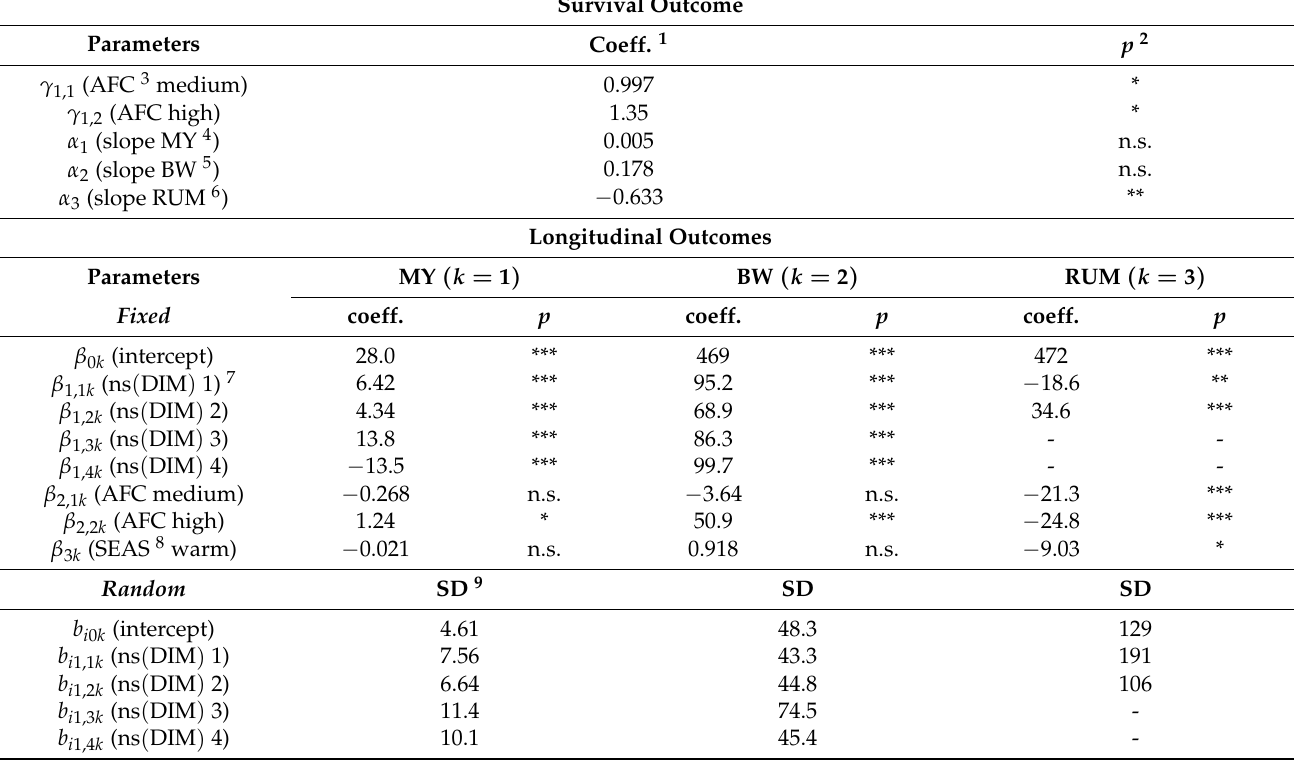
Table 3. Output from the fitted multivariate joint model in one dataset. Survival